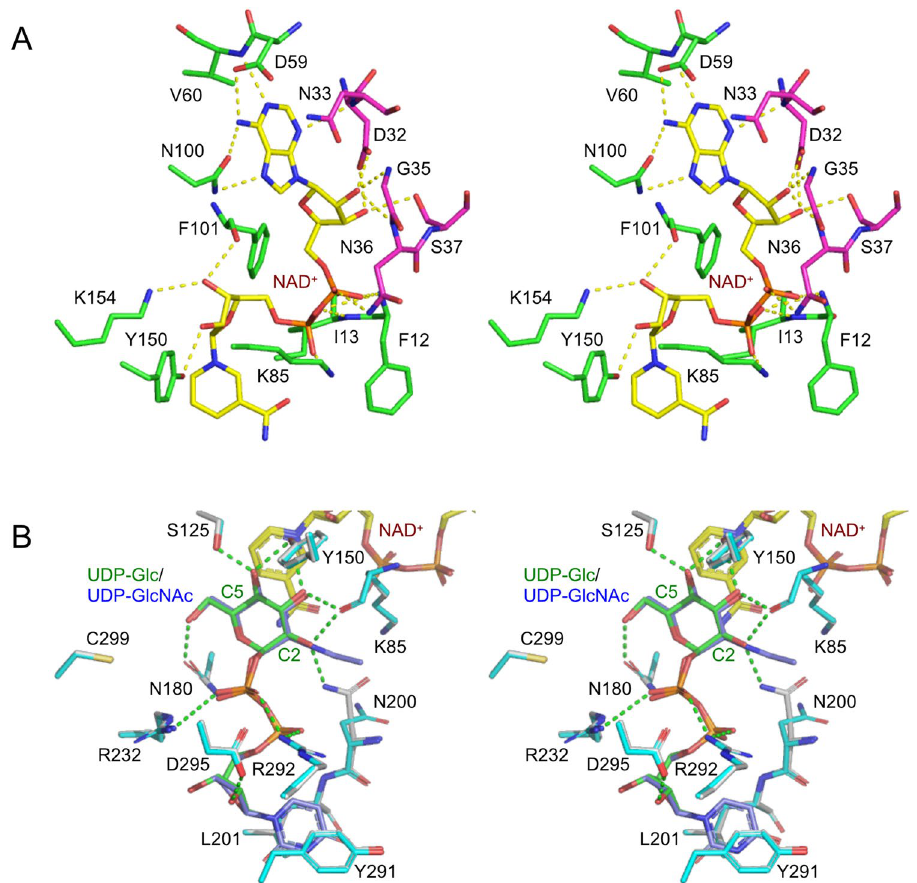
Figure 4. Stereoview of the cofactor and substrate binding sites of bGalE. ( A ) NAD + binding site of the UDP complex structure. ( B ) Superimposition of the complex structures with UDP-Glc (white and green for protein and UDP-Glc) and UDP-GlcNAc (cyan and blue for protein and UDP-GlcNAc). NAD + and hydrogen bonds are shown as yellow sticks and dotted lines,